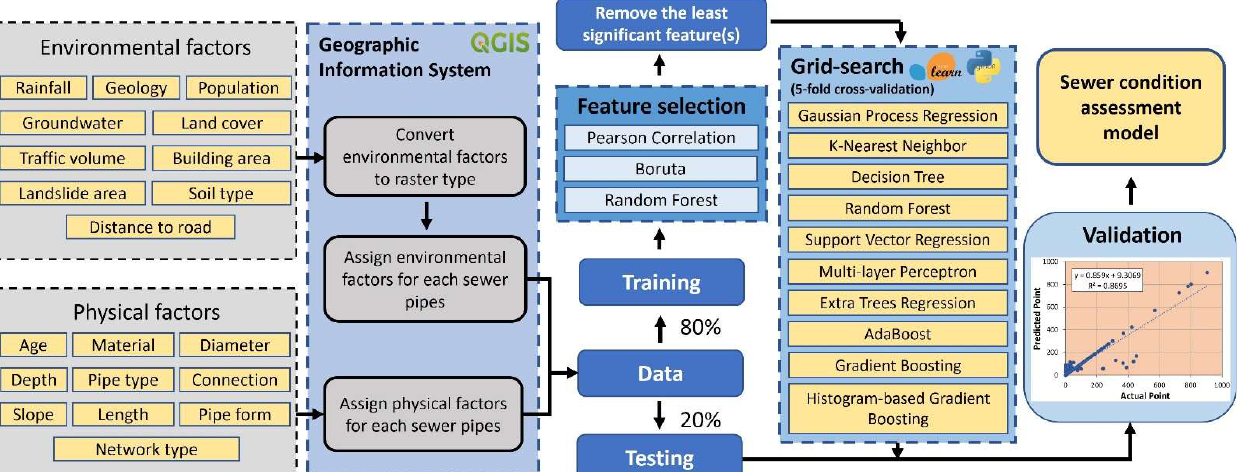
Figure 1. Location of the study area and sewer network (( a ) Location of Ålesund in Norway, ( b ) entire sewer network in Ålesund city, and ( c ) sewer network in a selected area of Ålesund).